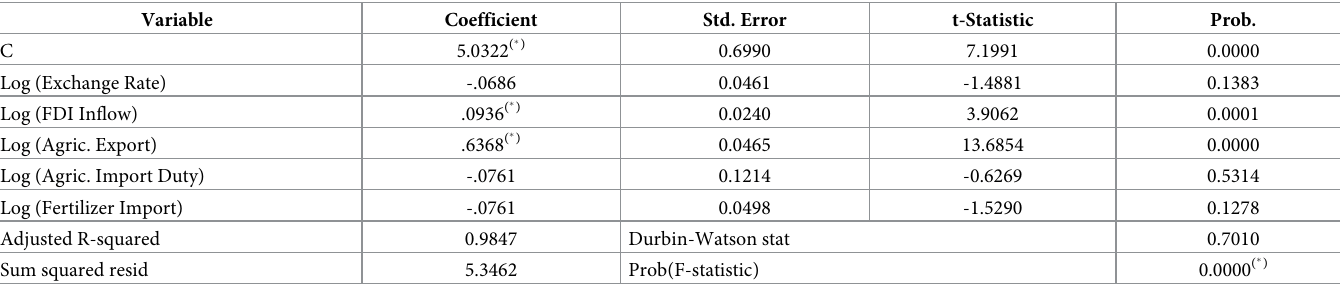
Table 3. Fixed effect model of the impact of EG on AVA in developing